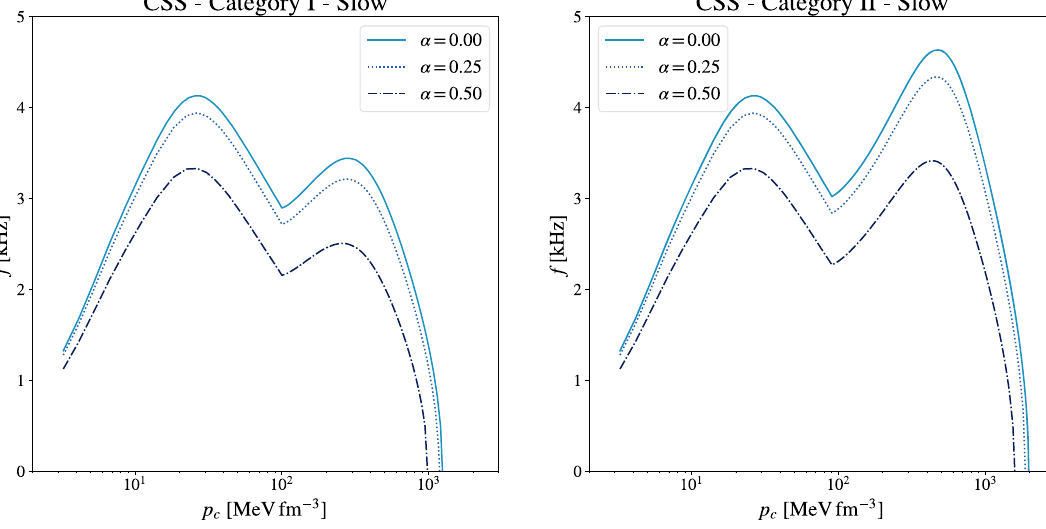
Fig. 2 Predictions for the fundamental linear eigenfrequency as a function of central pressure for charged twin stars considering slow conversions and the Categories I (left panel) and II (right panel) of the CSS parametrization. Note that the frequencies are not in the same scale as Fig.